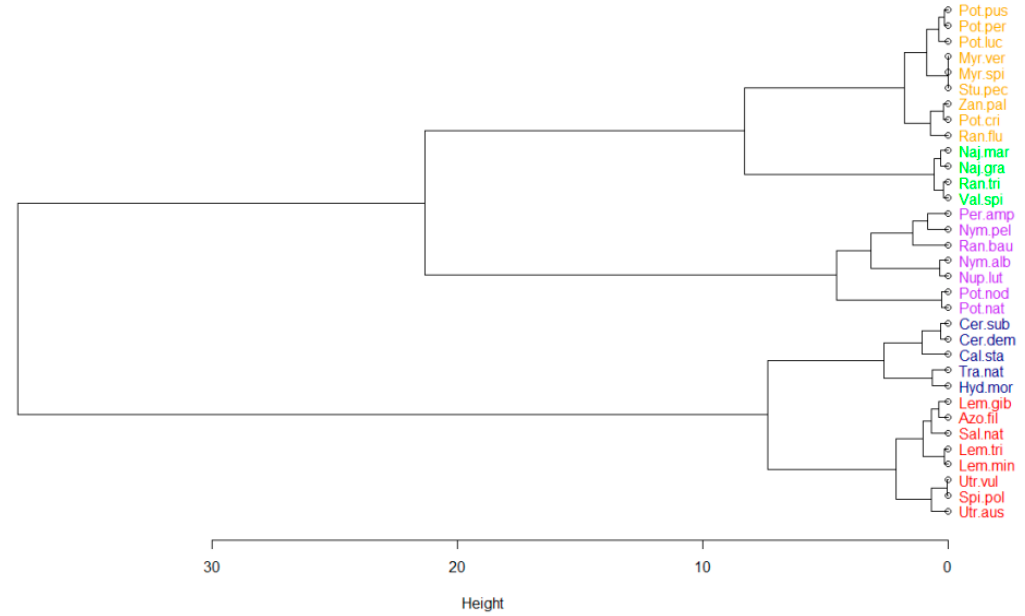
Figure 3. Dendrogram obtained from hierarchical clustering of the RLQ species scores based on Euclidean distances using Ward’s method. Colors correspond to the five functional groups.